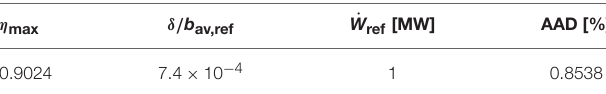
TABLE 2 | Overall heat-transfer coefficients assumed for the different heat-transfer processes. Taken from Hewitt (1994).